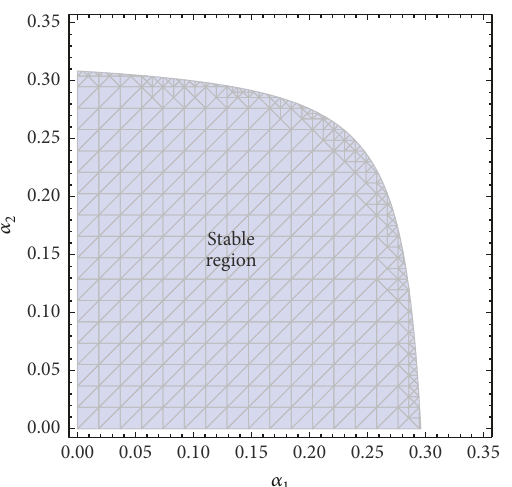
= 0.5 , and 𝛼 = 0.25 . 𝑖 2